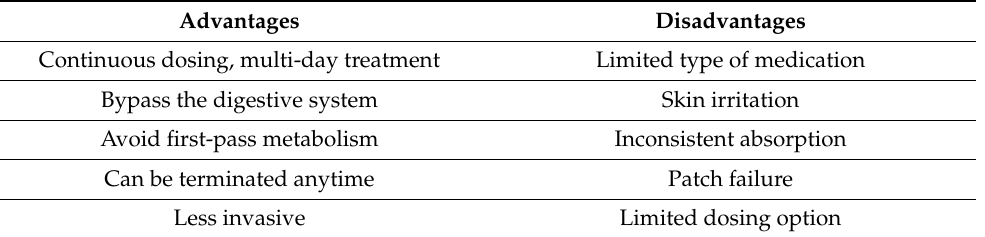
Table 1. Pros and cons of using transdermal patches.